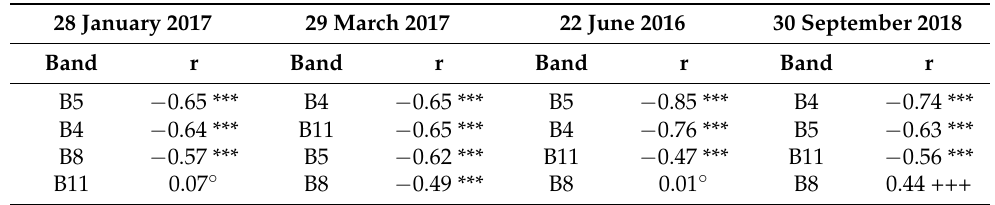
Table 5. Correlation coefficients between AGB and Sentinel-2 bands from 4 periods in descending order.